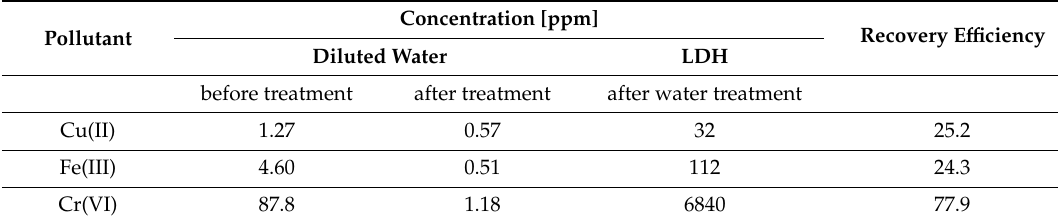
Table 1. Pollutant amount in the diluted wastewater before and after treatment with the NiAl-NO 3 LDH. Pollutant